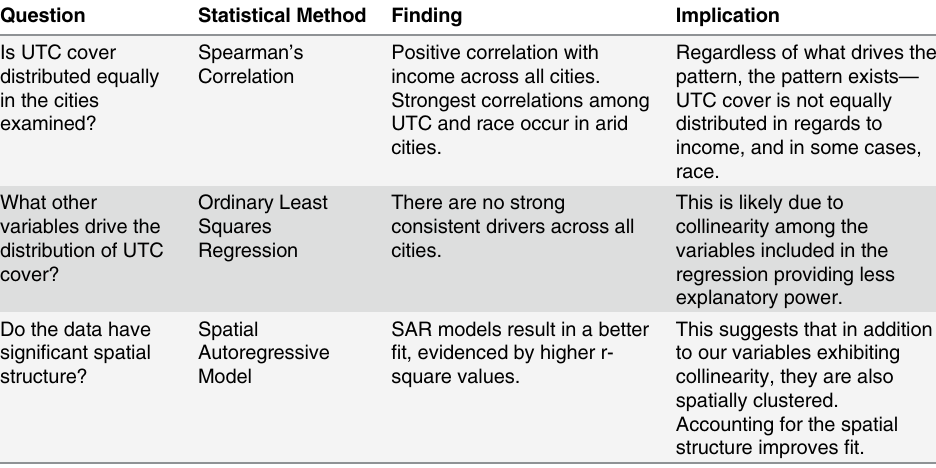
Table 5. Statistical Methods